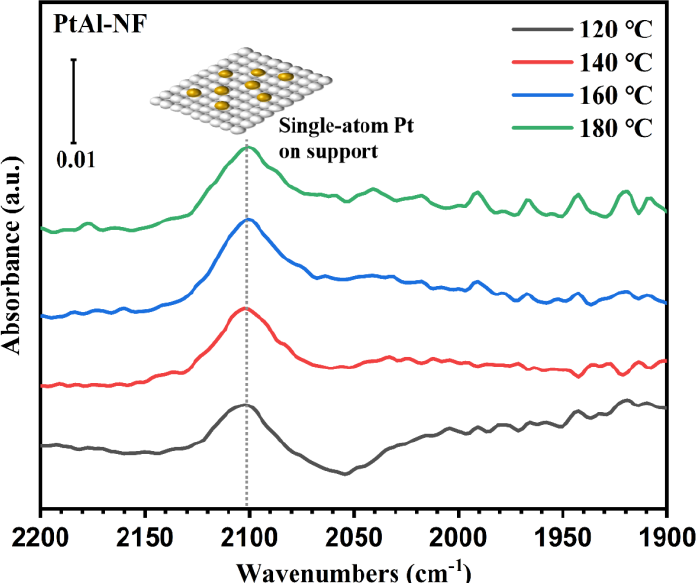
Figure 6. In situ DRIFT spectra over PtAl − NF at temperatures from 120 to 180 ◦ C. Reaction conditions: 700 ppm C 2 H 4 , 10% O 2 , N 2 balance, 17 mg catalyst, and 50 mL min −1 flow rate.